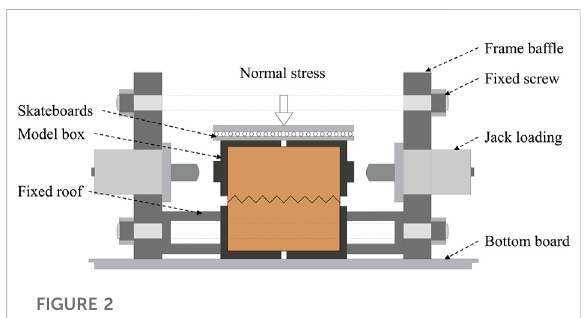
FIGURE 2 Schematic view of RJDT-A shear box.